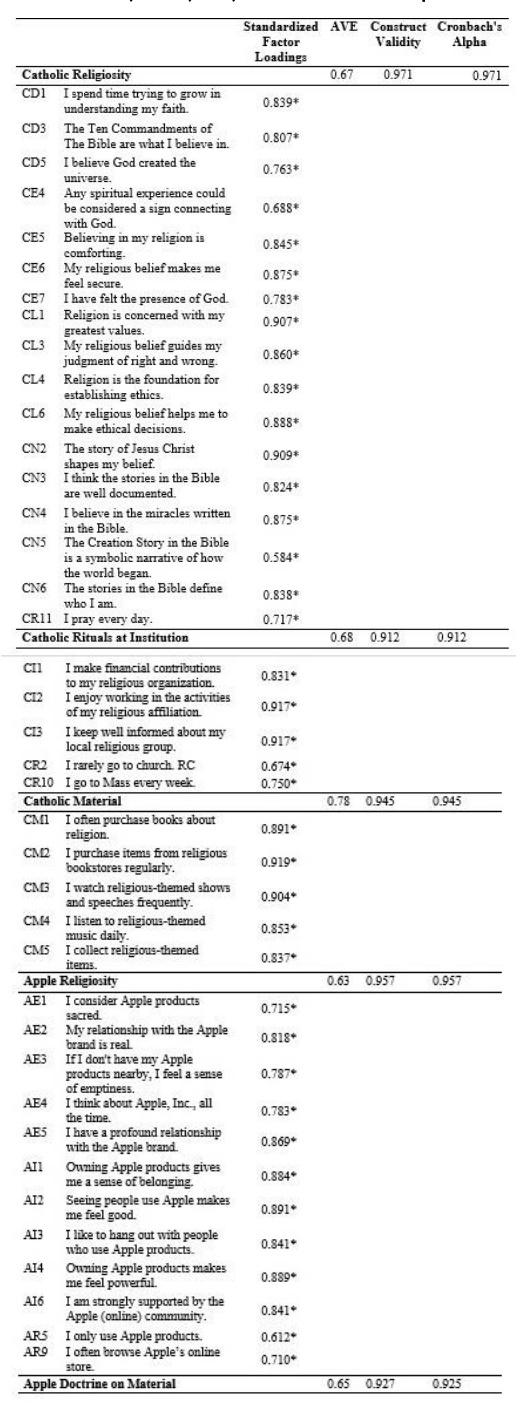
Table 2: Factor Loadings of Catholic and Apple Scales, AVE, CV, and Cronbach's